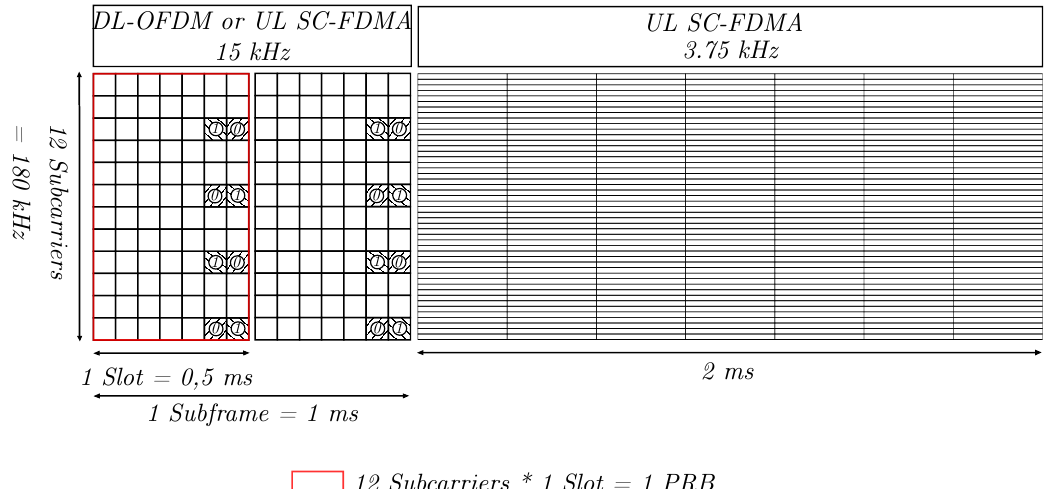
Figure 2. LTE resource grid. The NB-IoT Downlink (DL) is based on 15 kHz carrier spacing and OFDM, carrying reference symbols. The Uplink (UL) is based on 15 kHz or 3.75 kHz carrier spacing and SC-FDMA.